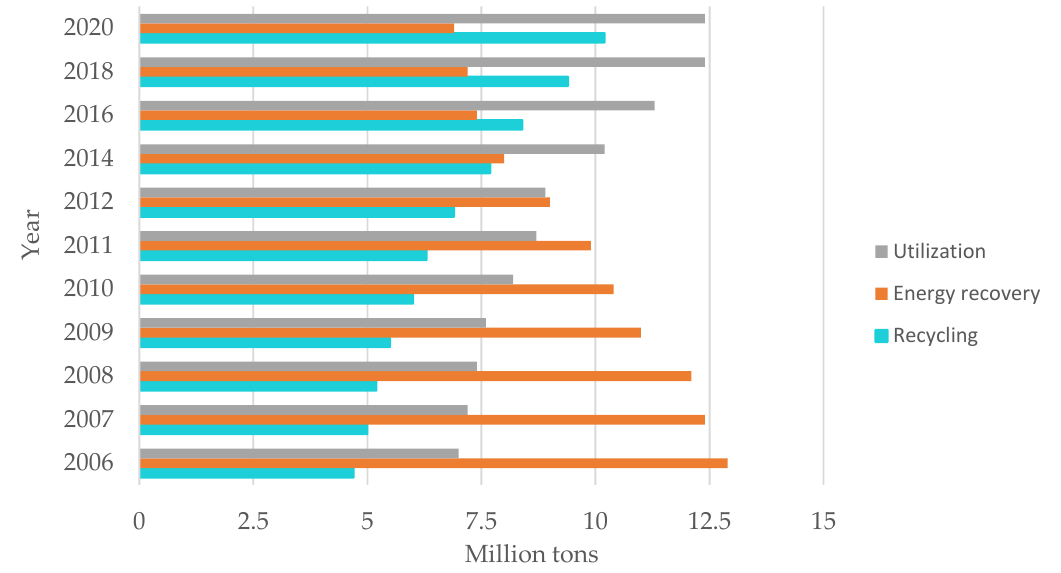
Figure 11. Waste management in 2020. Made based on [3].